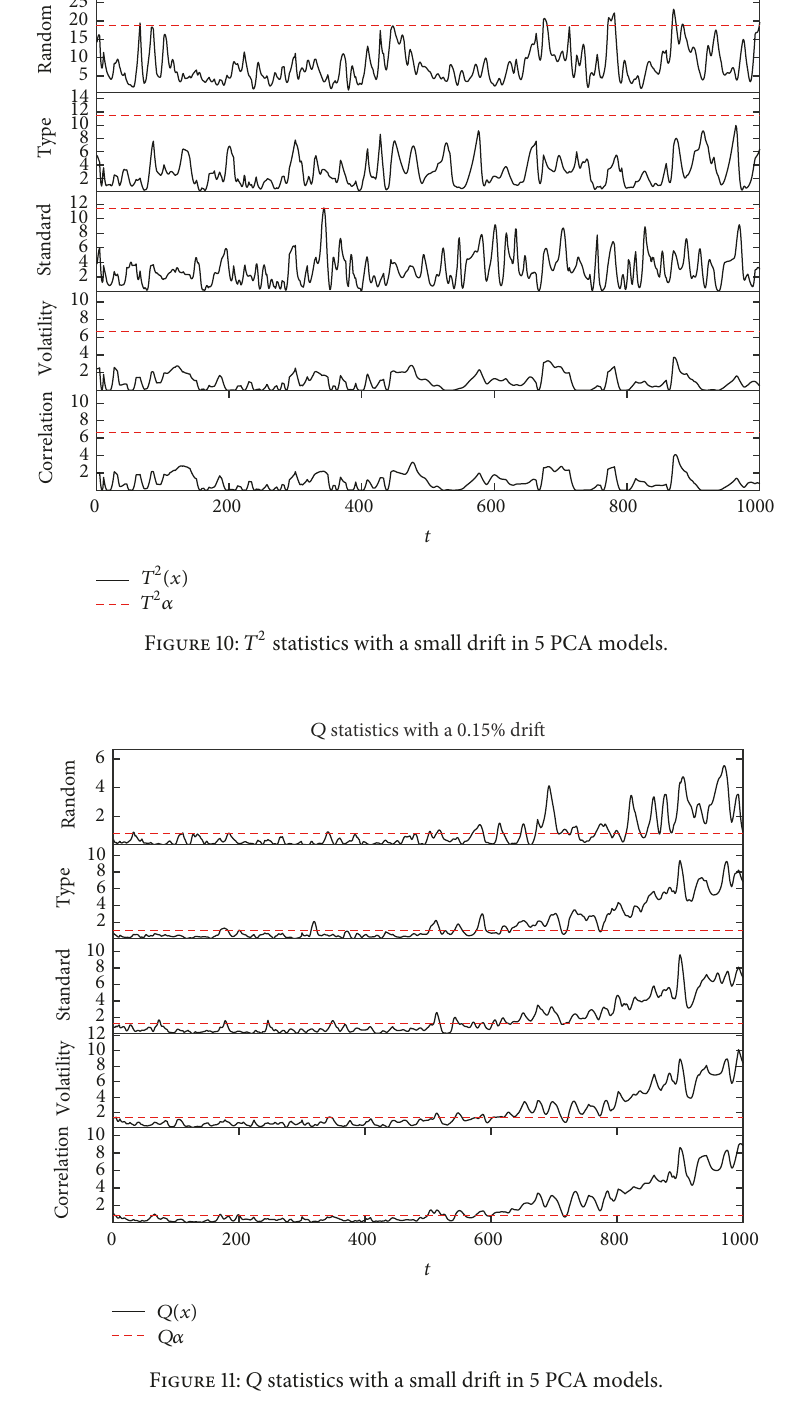
Figure 11: 𝑄 statistics with a small drift in 5 PCA